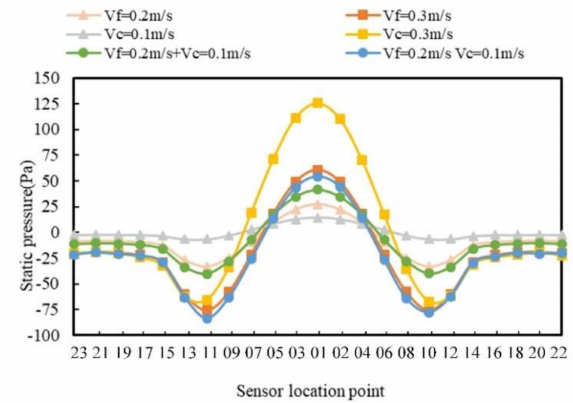
Figure 6. Static pressure distribution curve of the V f and V c in the opposite